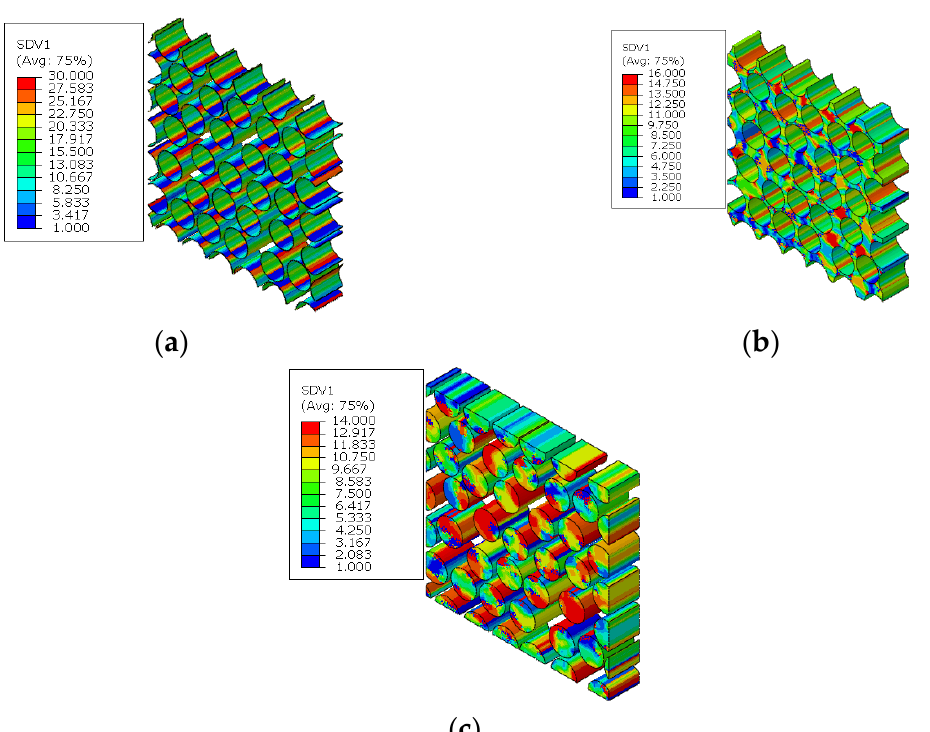
Figure 14. Stress distribution patterns for the fiber random distribution model. ( a ) longitudinal tensile loading; ( b ) transverse tensile loading; ( c ) longitudinal shear loading; ( d ) transverse shear loading.